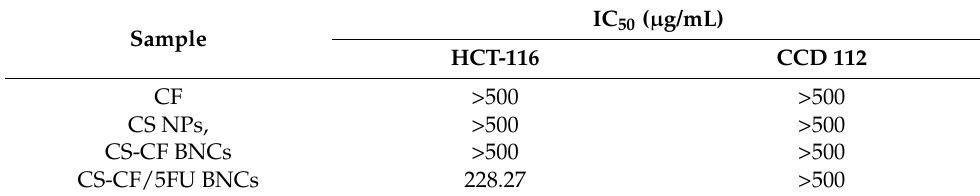
Figure 8. In vitro anticancer activity of ( a ) CF, ( b ) CS NPs, ( c ) CS-CF BNCs and ( d ) CS-CF/5FU BNCs against CCD112 colon normal and HCT116 CRC cell lines. Three independent experiments were performed and the data are expressed as the mean ± standard deviation for all triplicates within an individual experiment. Table 2. IC 50 of the synthesized